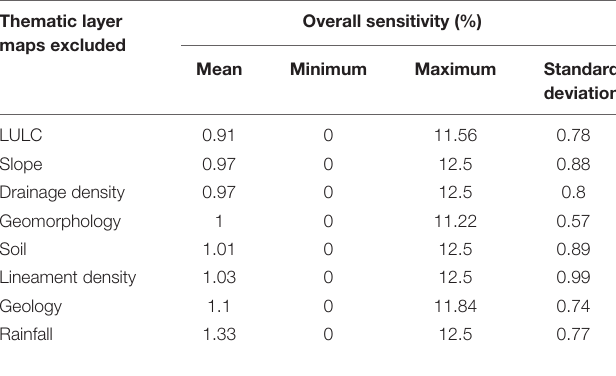
TABLE 1 | Statistics of the one-map removal sensitivity analysis. Thematic layer maps